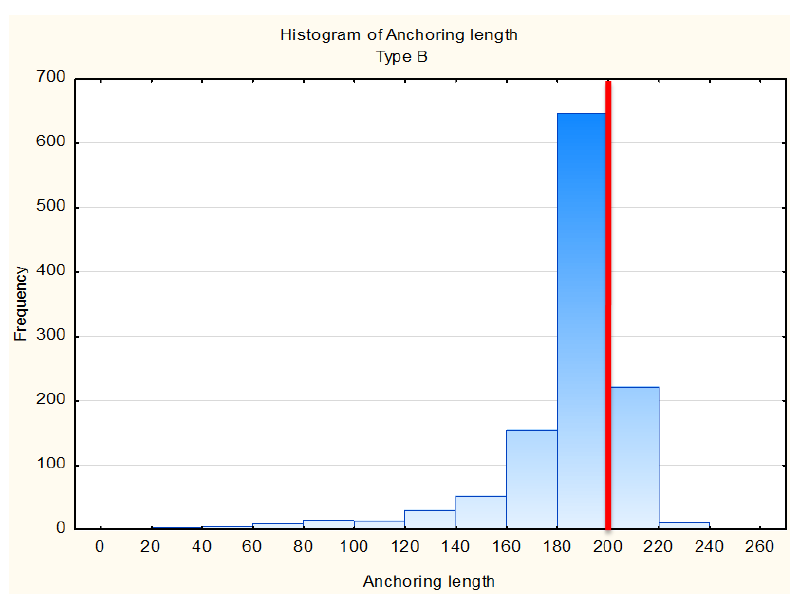
Figure 5. Histogram of anchoring length—type B.